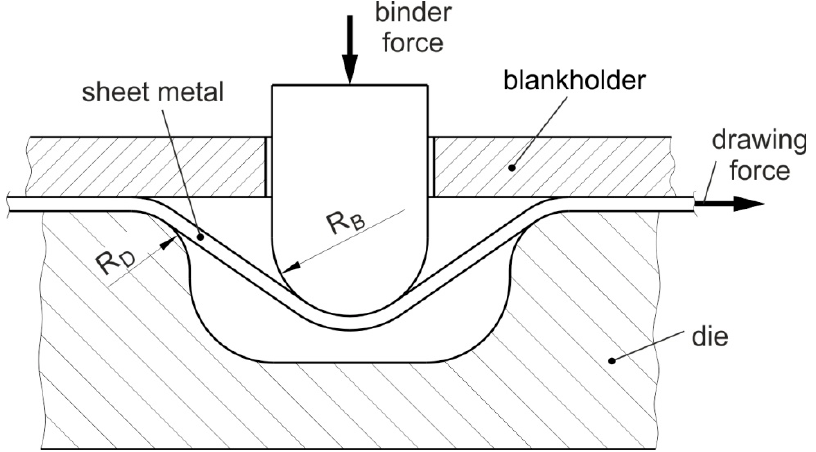
Figure 1. Cross-section of a typical drawbead with circular form.